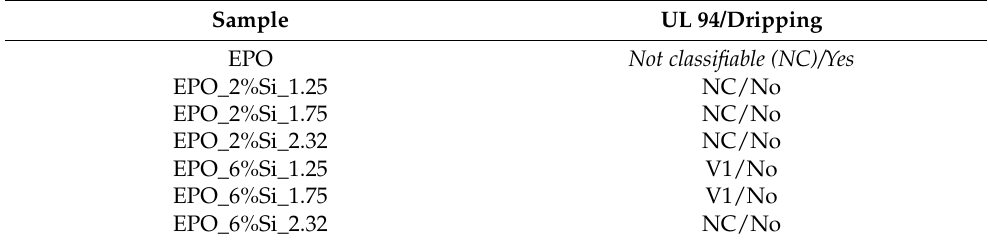
Table 2. Results of vertical flame spread tests for EPO and some nanocomposites.